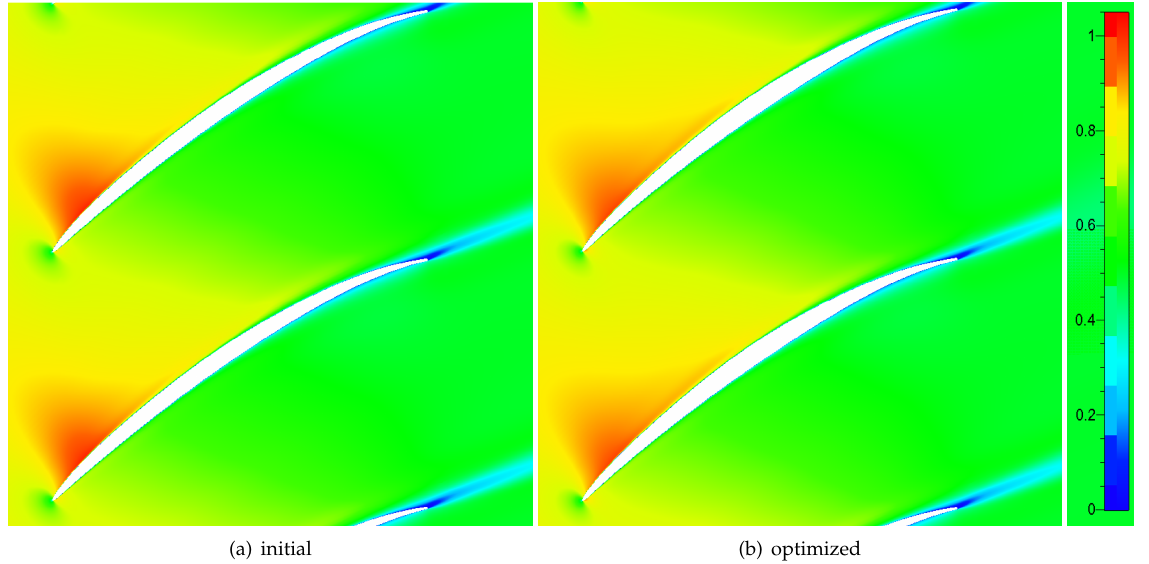
Figure 19. Absolute Mach number contours of initial and optimized blade